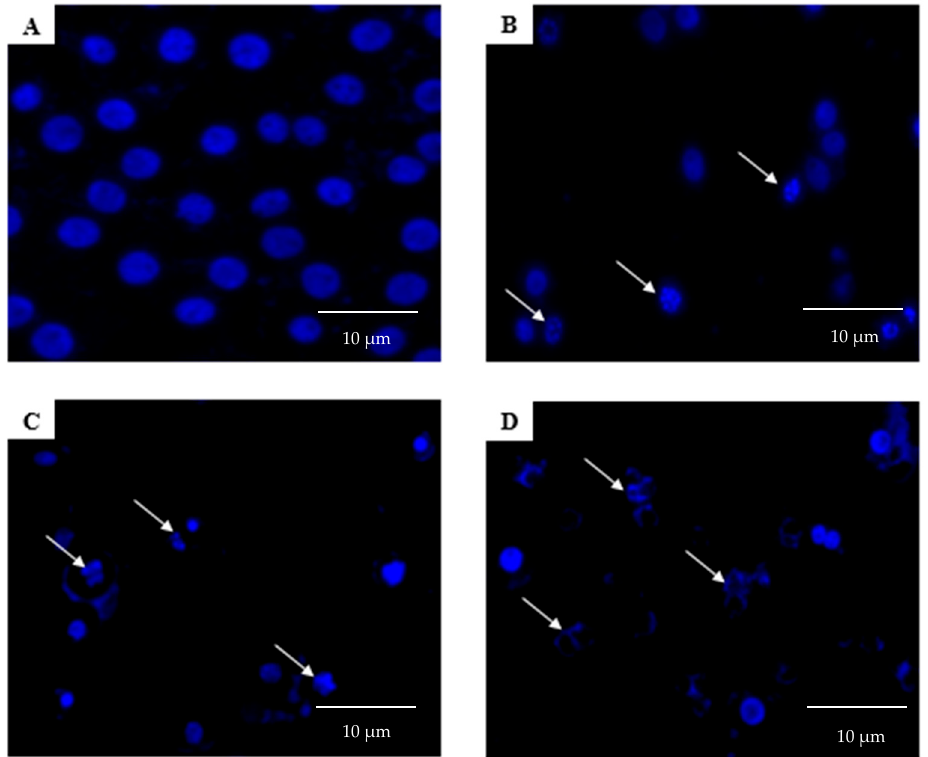
Figure 4. The fluorescent micrographs showing the effect of raphasatin on apoptosis, assessed by DAPI in MCF-7 cells. MCF-7 cells were treated with 9.84 µM (IC 50 ) concentration of raphasatin for 24 h ( B ), 48 h ( C ), and 72 h ( D ), and compared with the untreated cells ( A ). Images represent one of the three independent experiments. The arrows in B, C, and D show the nuclear fragmentation and chromatin condensation commensurate, with apoptosis.